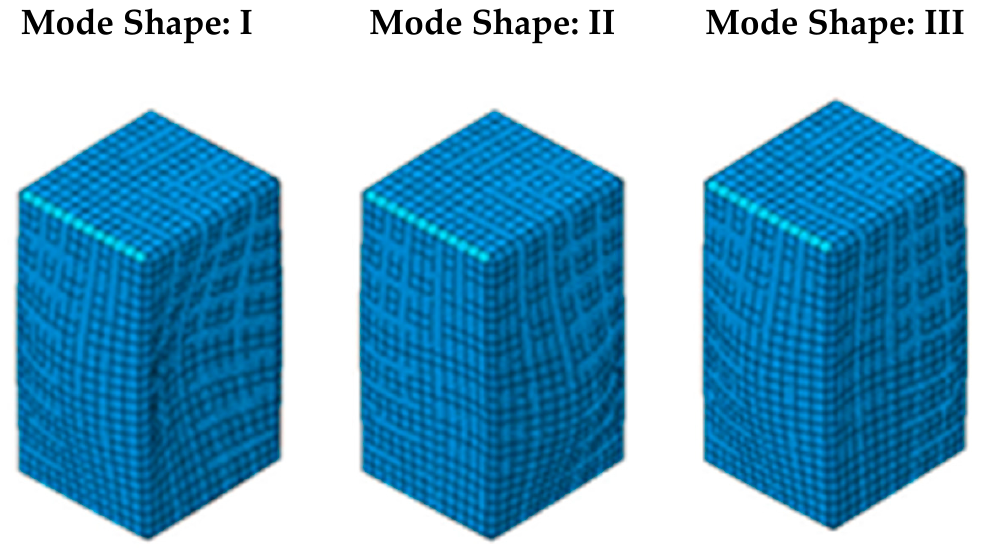
Figure 5. The first three mode shapes of buckling of compartment.